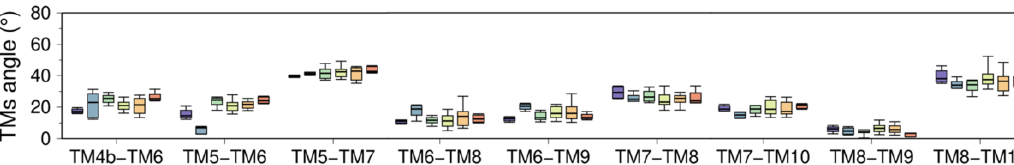
Figure B3. Rotation angle (R) calculated for ( A ) P-A domains and displacement distance (T) for ( B ) A-N, ( C ) P-N, and ( D ) P-A domains. A total of 74 SERCA1a structures were compared, using 2c9m as reference.